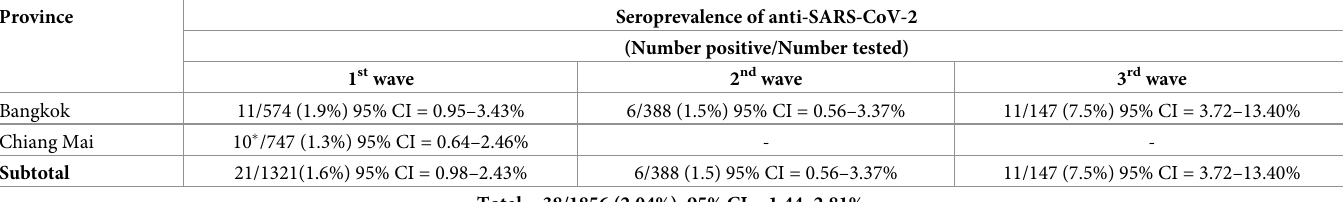
Table 3. Seroprevalence of anti-SARS-CoV-2 antibodies in participants who shared workplaces or lived in communities with reported COVID-19 cases. Province